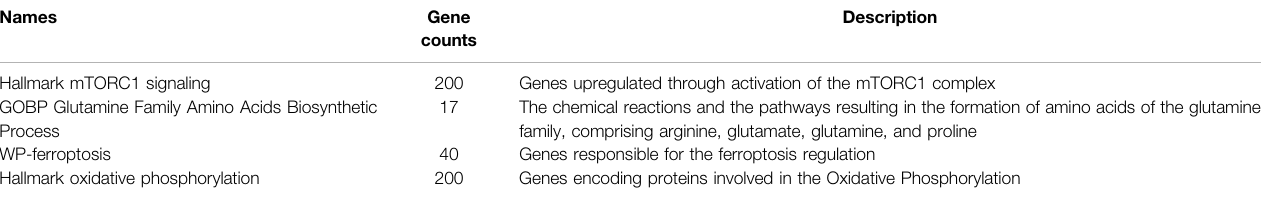
TABLE 2 | Description of the gene sets for